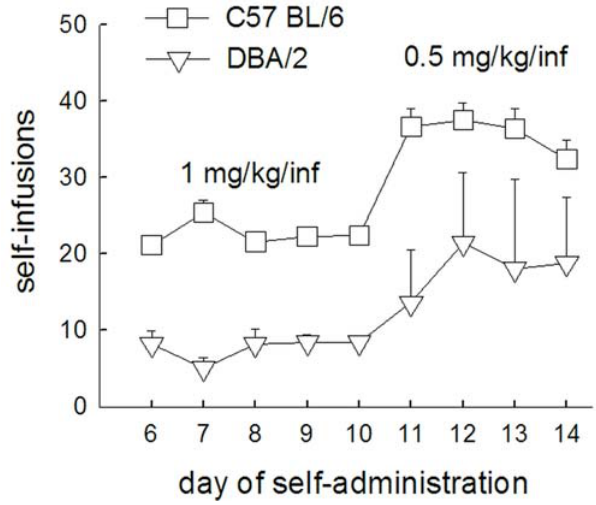
Figure 2. Cocaine self-administration in C57 and DBA mice in a study where both strains acquired at 1 mg/kg/infusion. The graph shows the number of self-infusion on the last 5 days of acquisition (day 6–10) and the transition to a 0.5 mg/kg/infusion dose (day 11–14). At the 0.5 mg/kg dose, DBA mice show a number of self- infusions that is comparable to that of the C57 mice at the 1 mg/kg/ infusion dose. Symbols represent mean 6 SEM. C57 (squares) n =8, DBA (triangles) n =5.